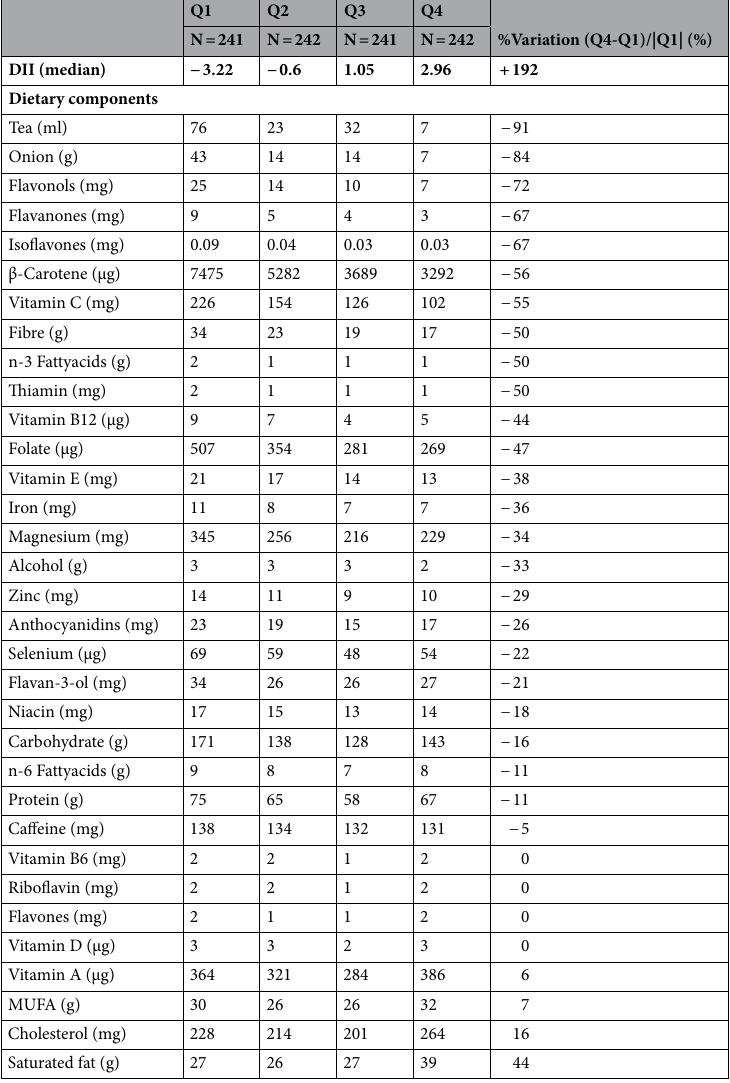
Table 2. Median nutritional intake per day by quartile of DII among controls. The CECILE study, France, 2005–2007. MUFA monounsaturated fatty acids, PUFA polyunsaturated fatty acids.